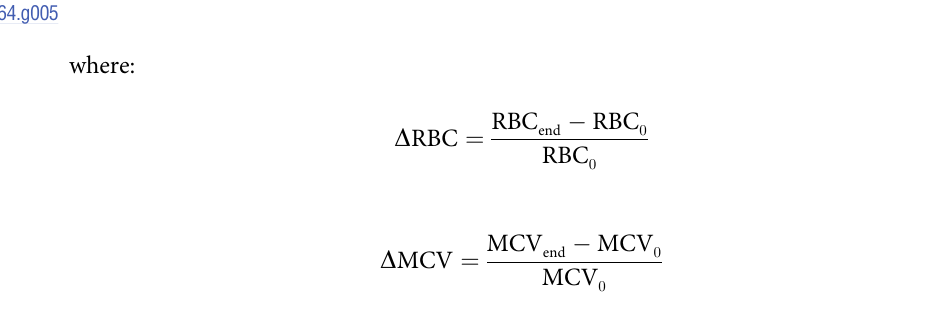
Fig 5. Correlation between dialysis-induced changes in mean corpuscular red cell volume, dialysate sodium concentration and change in plasma sodium concentration during dialysis. Dialysis-induced changes in mean corpuscular red cell volume ( Δ MCV) paired with a) dialysate sodium concentration (Na d ) and b) change in plasma sodium concentration ( Δ Na pl ) during all analyzed hemodialysis sessions with linear regression fit (solid lines) and 95% confidence bounds (dotted